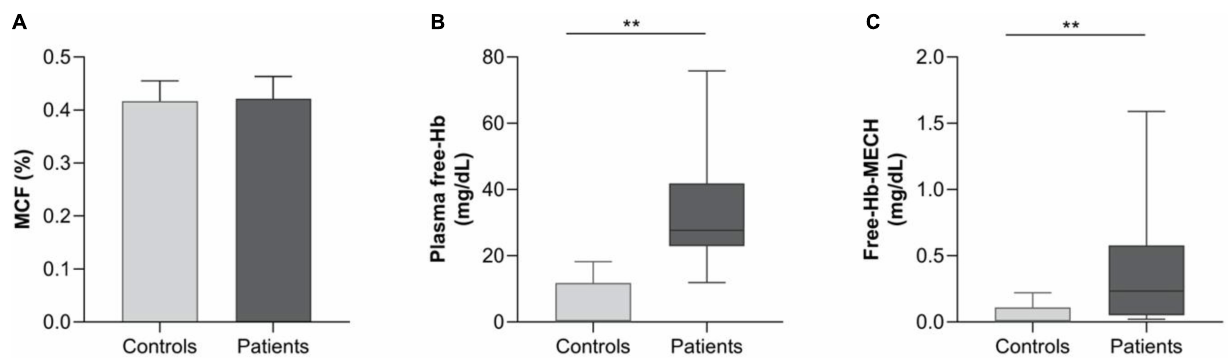
FIGURE 1 | Presenting hemolysis markers in patients (PTs) compared to the control group (CTLs). (A) The bar graph illustrates the percentage of mean cell fragility (MCF) in the two groups (patients vs. controls). Box and whisker plot [using the Tukey method] illustrating: (B) plasma free Hemoglobin (Hb) in mg/dL in patients vs.